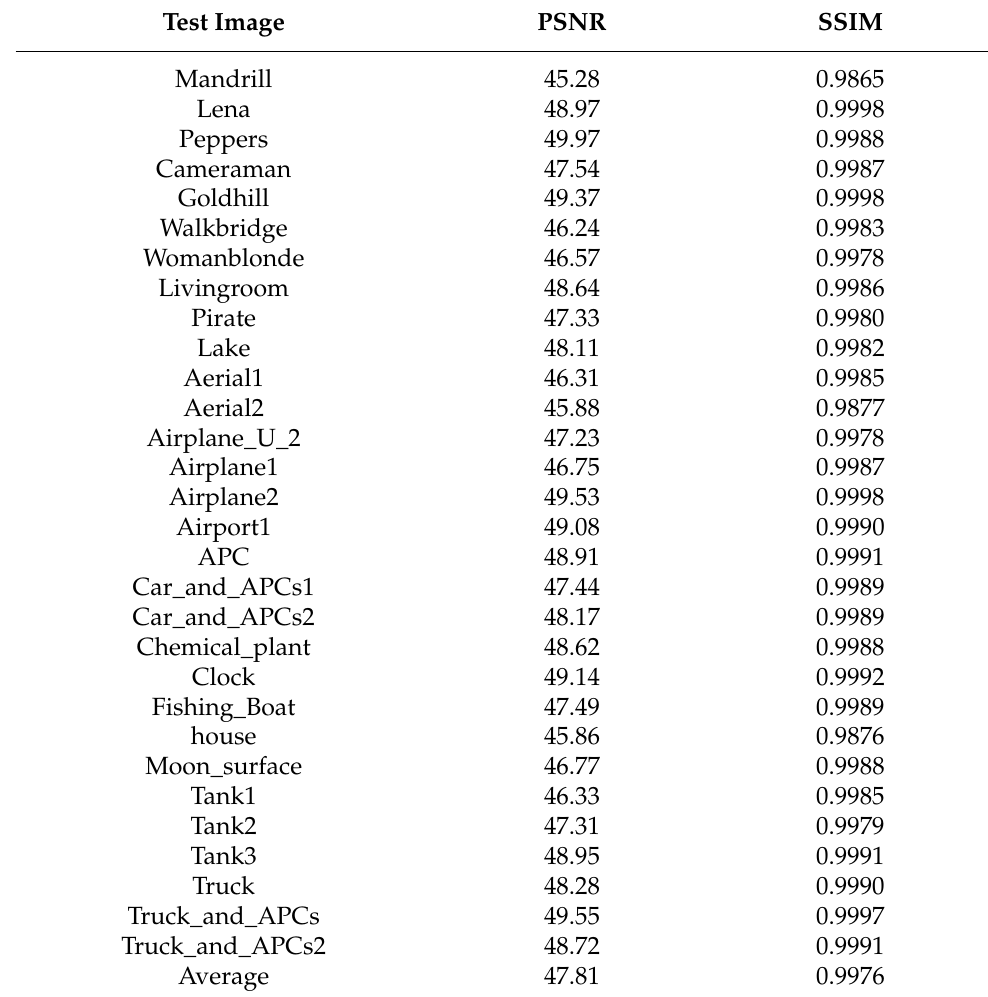
Table 1. Watermark imperceptibility measured in terms of PSNR (dB) and